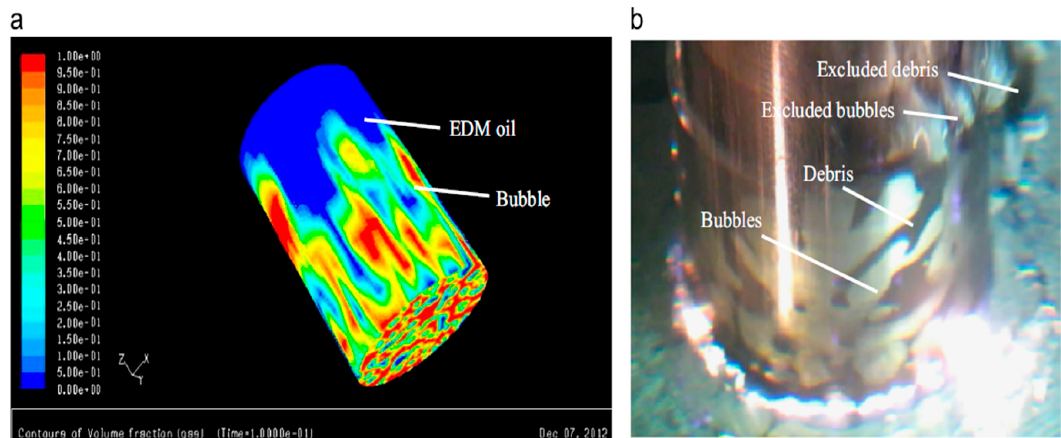
Figure 12. ( a ) Simulation and ( b ) observation experimental results of the bubble and debris movement [208].